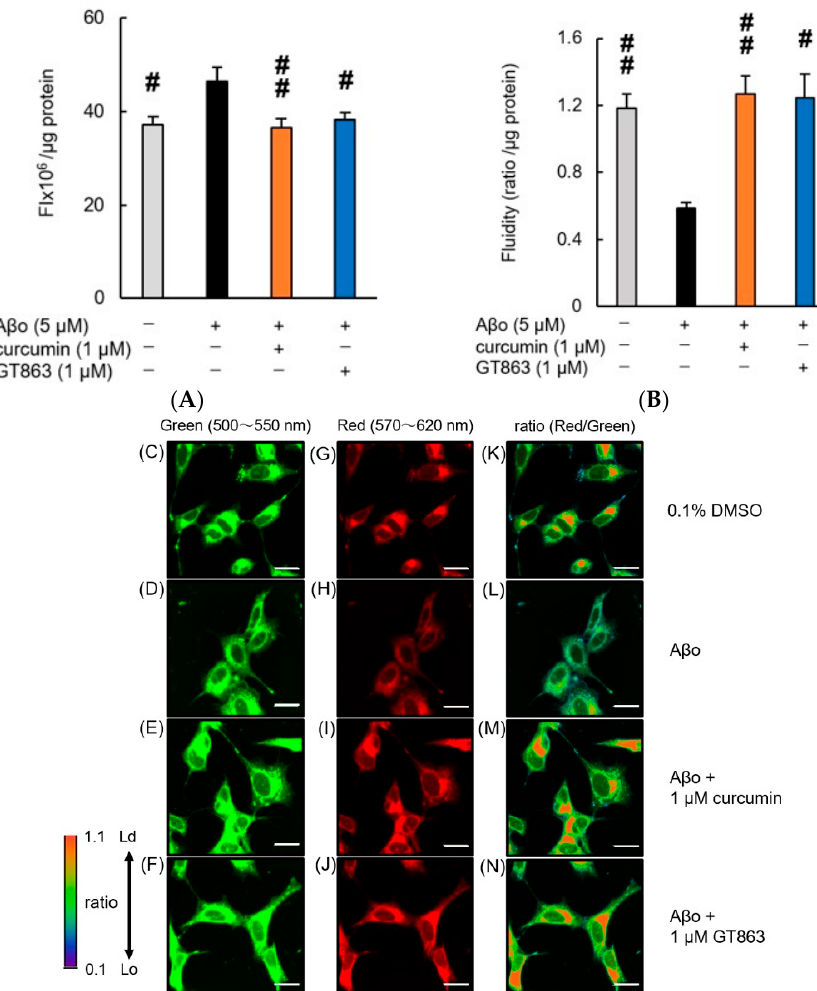
Figure 6. Effect of curcumin and GT863 on membrane-phospholipid peroxidation levels, cell-membrane fluidity, and membrane-lipid order-imaging dye. ( A ) The levels of membrane-phospholipid peroxidation in A β o-stimulated SH-SY5Y cells was evaluated using DPPP. The levels of membrane-phospholipid per- oxidation in SH-SY5Y cells exposed to 5 µ M A β o and treated with A β o + 1 µ M curcumin or A β o + 1 µ M GT863. In the absence of 5 µ M A β o, the membrane-phospholipid peroxidation levels of control, 1 µ M curcumin-treated, and 1 µ M GT863-treated cells were 33.32 ± 2.48, and 31.24 ± 1.72 fluorescence in- tensity × 10 6 / µ g protein, respectively (no significant difference, n = 10, Tukey). +: inclusion of 5 µ M A β o, 1 µ M curcumin, 1 µ M GT863; − : non-inclusion. The p -values in ANOVA were < 0.001.